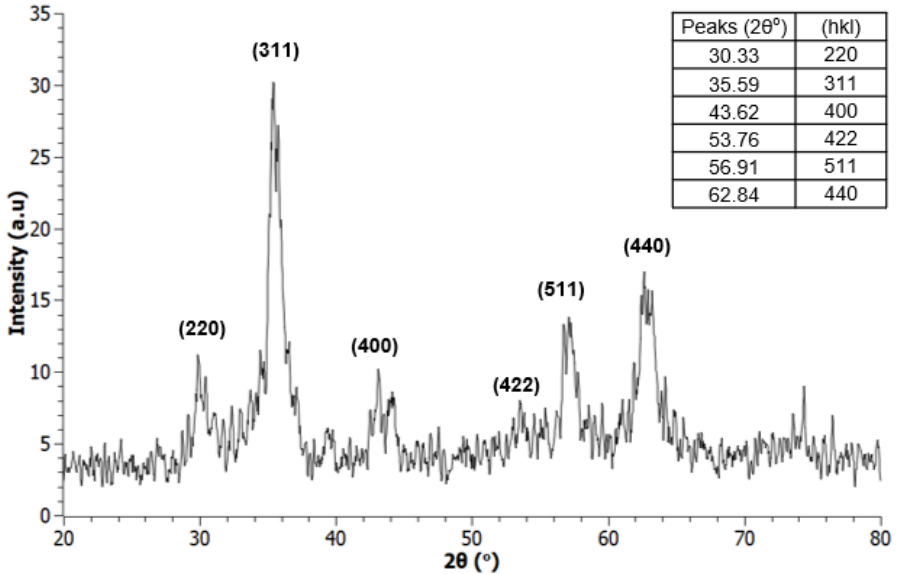
Figure 4. XRD spectra of Fe 3 O 4 NHS (magnetite), autoclaved at 180 ◦ C for 8 h.